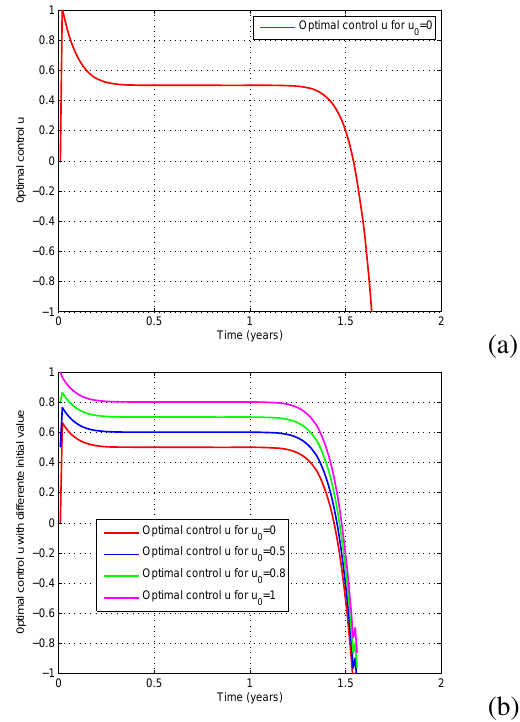
Fig. 3. Numerical simulations of a control u : (a) and (b)